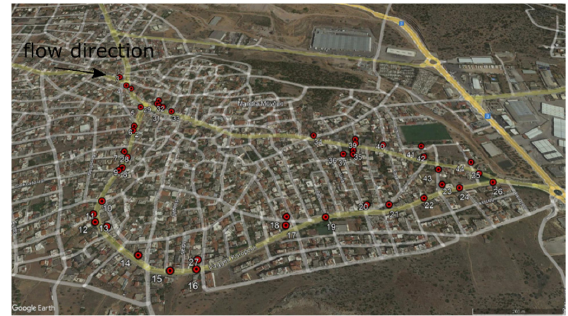
Hydrology 2022 , 9 , x FOR PEER REVIEW Figure 3. Location of observation points across Mandra town. Figure 3. Location of observation points across Mandra town.